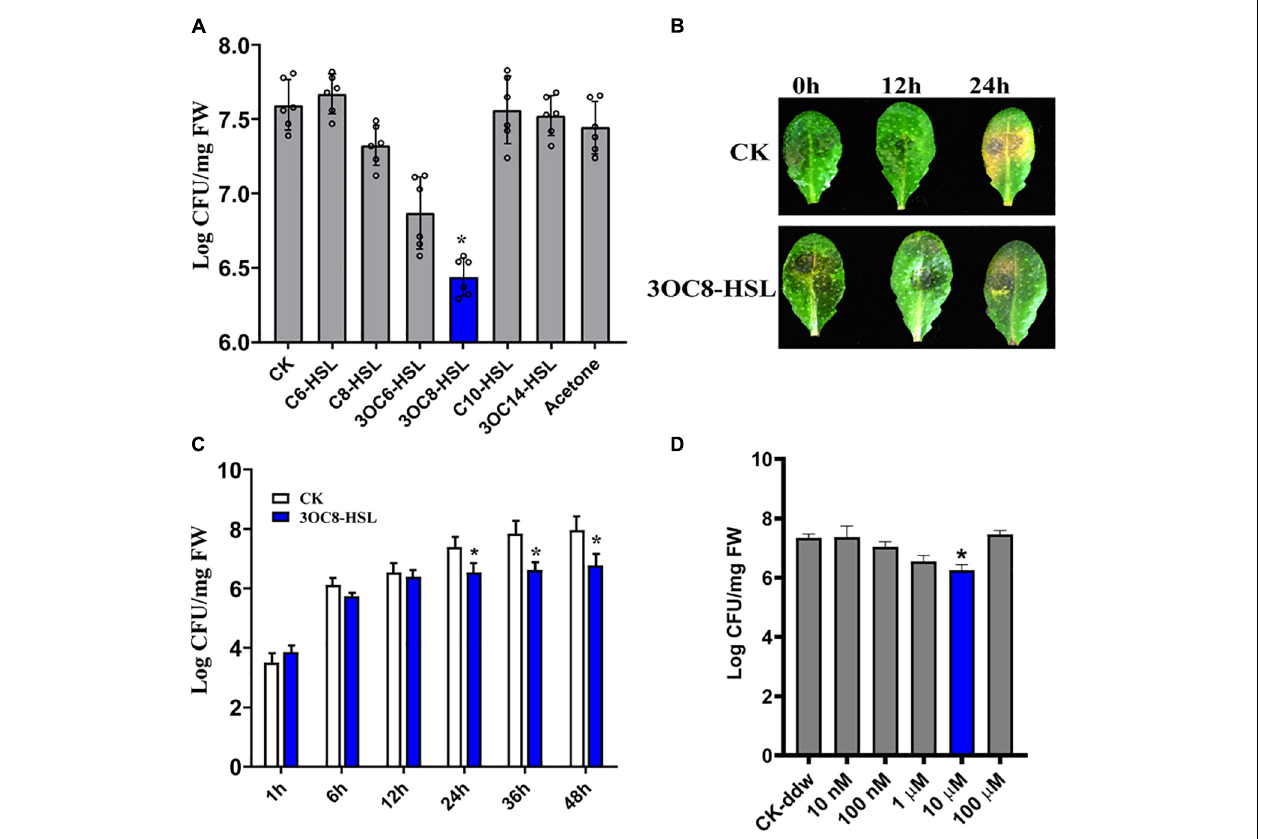
FIGURE 1 | Enhanced resistance of 3OC8-HSL-treated Arabidopsis against Pcc . (A) Proliferation of Pcc in the leaves of Arabidopsis plants (grown in a hydroponic system) in which the roots were pretreated with 10 µ M of different AHL compounds for 48 h, and the leaves were subsequently spray-inoculated with 10 7 CFU/mL Pcc . CFUs were counted at 24 h post-inoculation. “CK” is for wild type Arabidopsis Col-0 inoculated with MgCl 2 . The input of each sample and control were similar, around 10 3 CFU/g FW. (B) Symptoms of Pcc infection on wild-type Arabidopsis pretreated with 10 µ M 3OC8-HSL. The disease symptoms were recorded at 24 h after inoculation. (C) Inhibitory effect of 3OC8-HSL on Pcc growth in Arabidopsis. The leaves (grown in hydroponic system) were inoculated with 10 7 CFU/mL Pcc at 48 h after pretreatment with 10 µ M 3OC8-HSL at the roots. CFUs were counted at different hour intervals post-inoculation. Data represent the means of three independent biological replicates ± standard deviation (SD). (D) Different priming effects of different concentrations of 3OC8-HSL. The experiments were performed with six leaves per treatment, and similar results were obtained in three independent experiments. Asterisks indicate a statistically significant difference between the AHL-pretreated and the water-treated plants (ANOVA test, * P < 0.05). Values are means ± SD of six independent